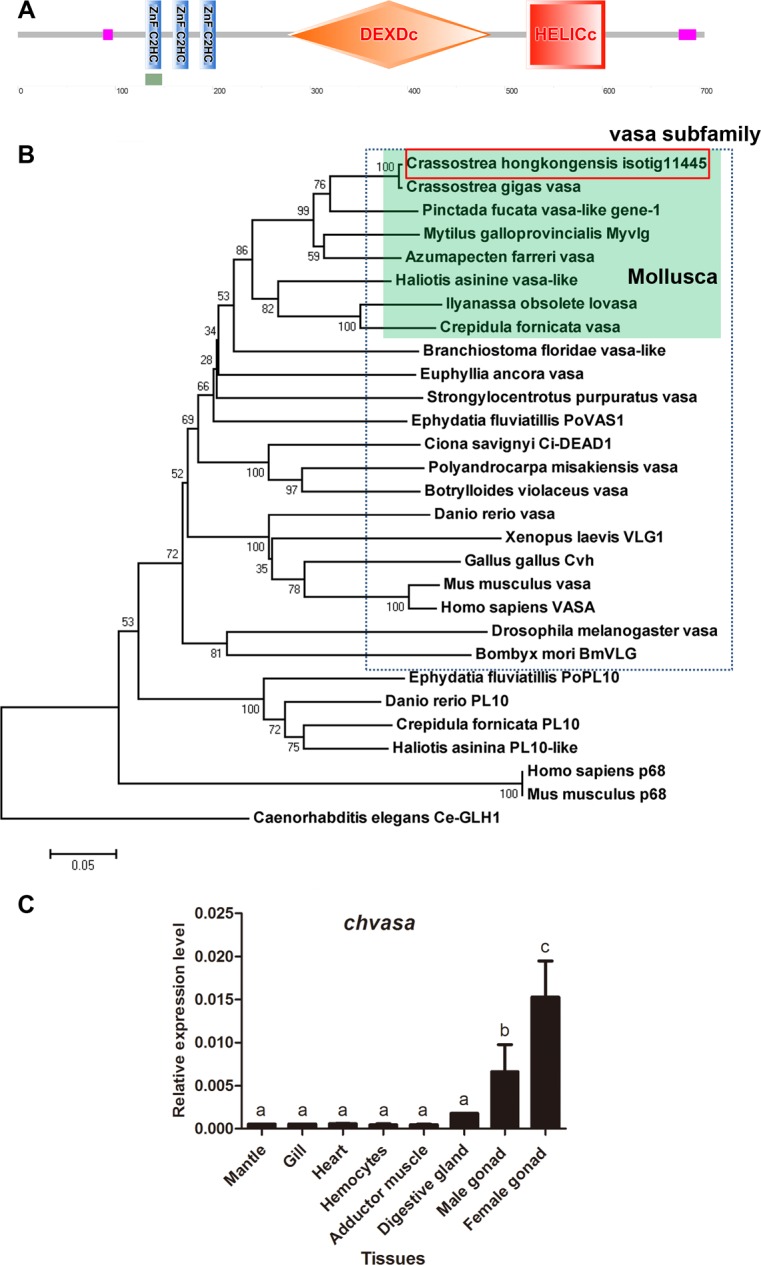
Vasa gene identified in the Crassostrea hongkongensis transcriptome and its expression profile.(A) Domain structure of the C.hongkongensis vasa ortholog. (B) Molecular phylogenetic tree of Vasa subfamily and related proteins. Bootstrap values from 1000 trials are indicated at each branch node. The scale bar indicates 0.05 amino acid replacements per site. C elegans Ce-GLH-1 was used as an outgroup. The transcript encoding Chvasa, indicated by a red open box, is properly aligned to the clade of molluscan Vasa colored by green. The Vasa subfamily proteins are enclosed by the dotted lines. For the GenBank accession numbers of the reference sequences, see S3 Table. (C) Expression profile of C.hongkongensis vasa ortholog (Chvasa) in adult tissues with mean ± s.e.m. as error bars (n = 5).